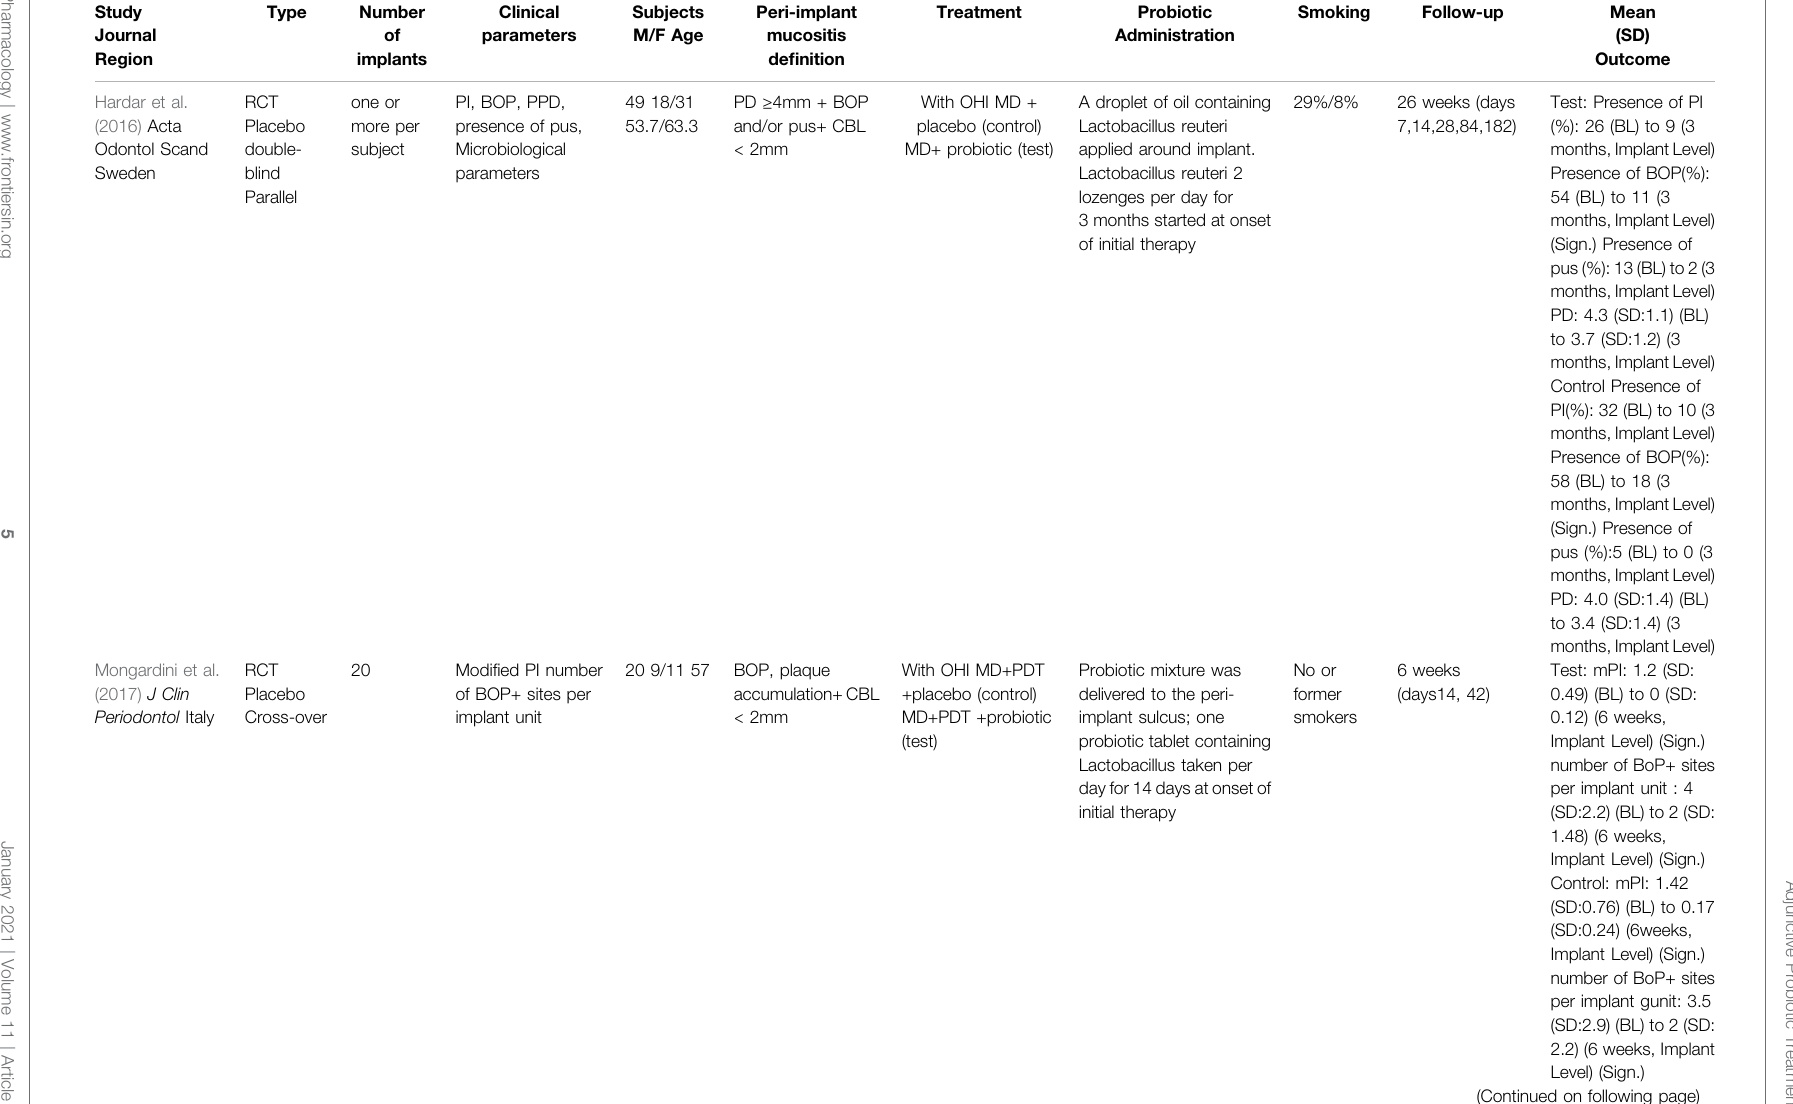
TABLE 2 | Characteristics of the included